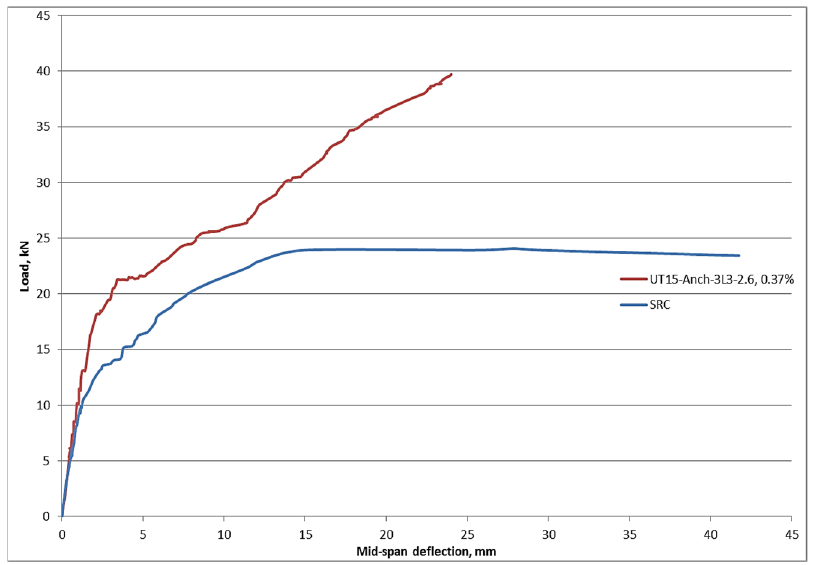
Figure 23. Load-deflection behaviour at mid-span of uni-axial reinforcement (tow) and steel-reinforced concrete beams.